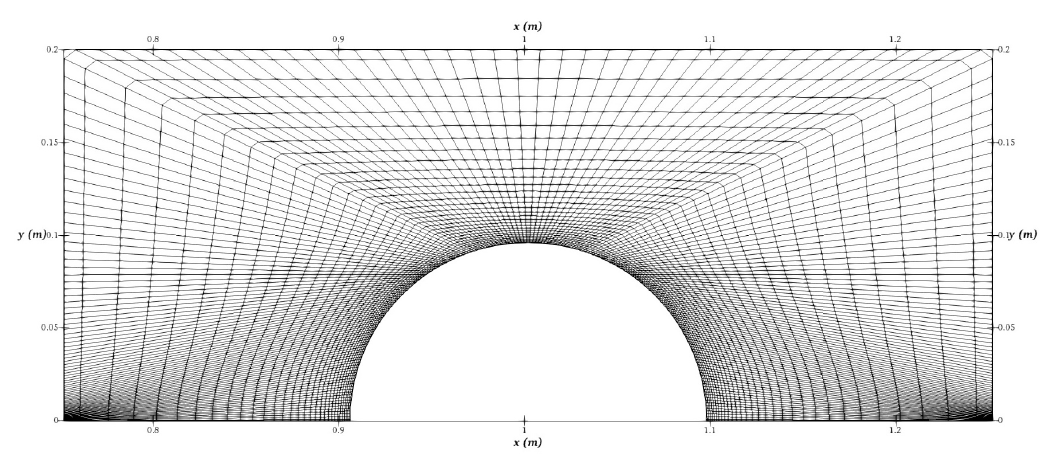
Figure 7. Computational mesh around the semicylindrical